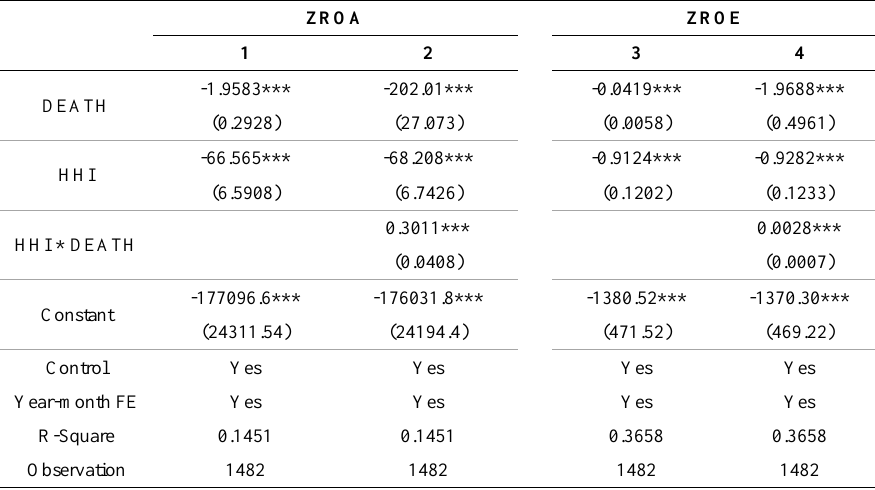
Table 6. Robustness Tests; Alternative Measures of COVID-19